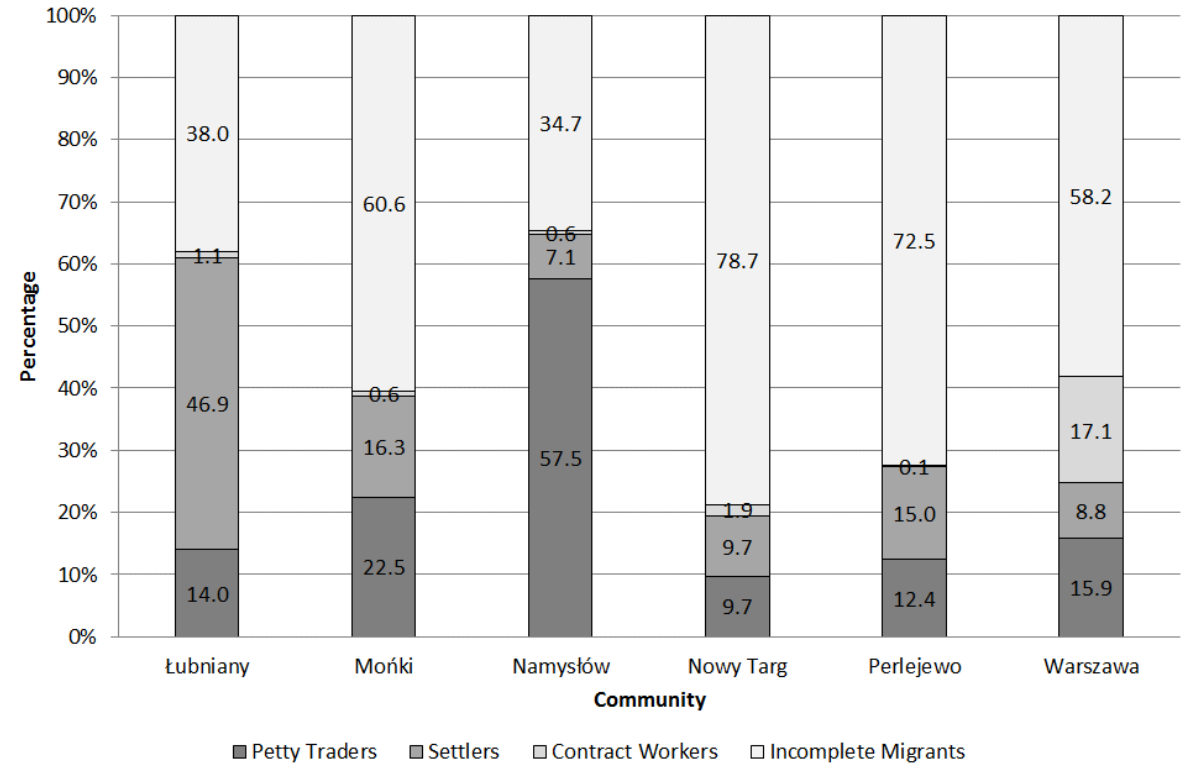
Source: Jaźwińska and Okólski